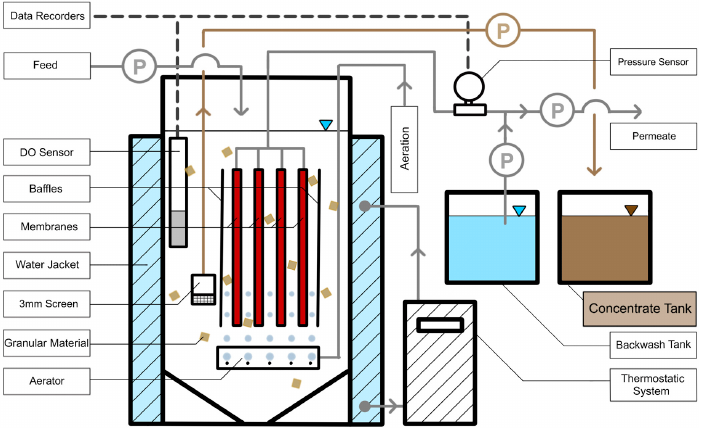
Figure 1. Schematic flow diagram of the experimental system. The shaded area indicates the closed loop water circulator for temperature control.